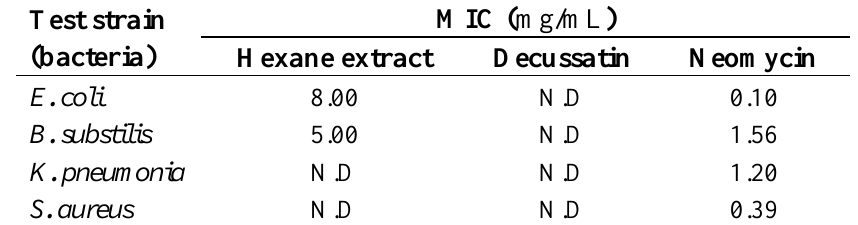
Table 1. Minimum Inhibitory Concentration (MIC) of Decussatin and Hexane extract against four